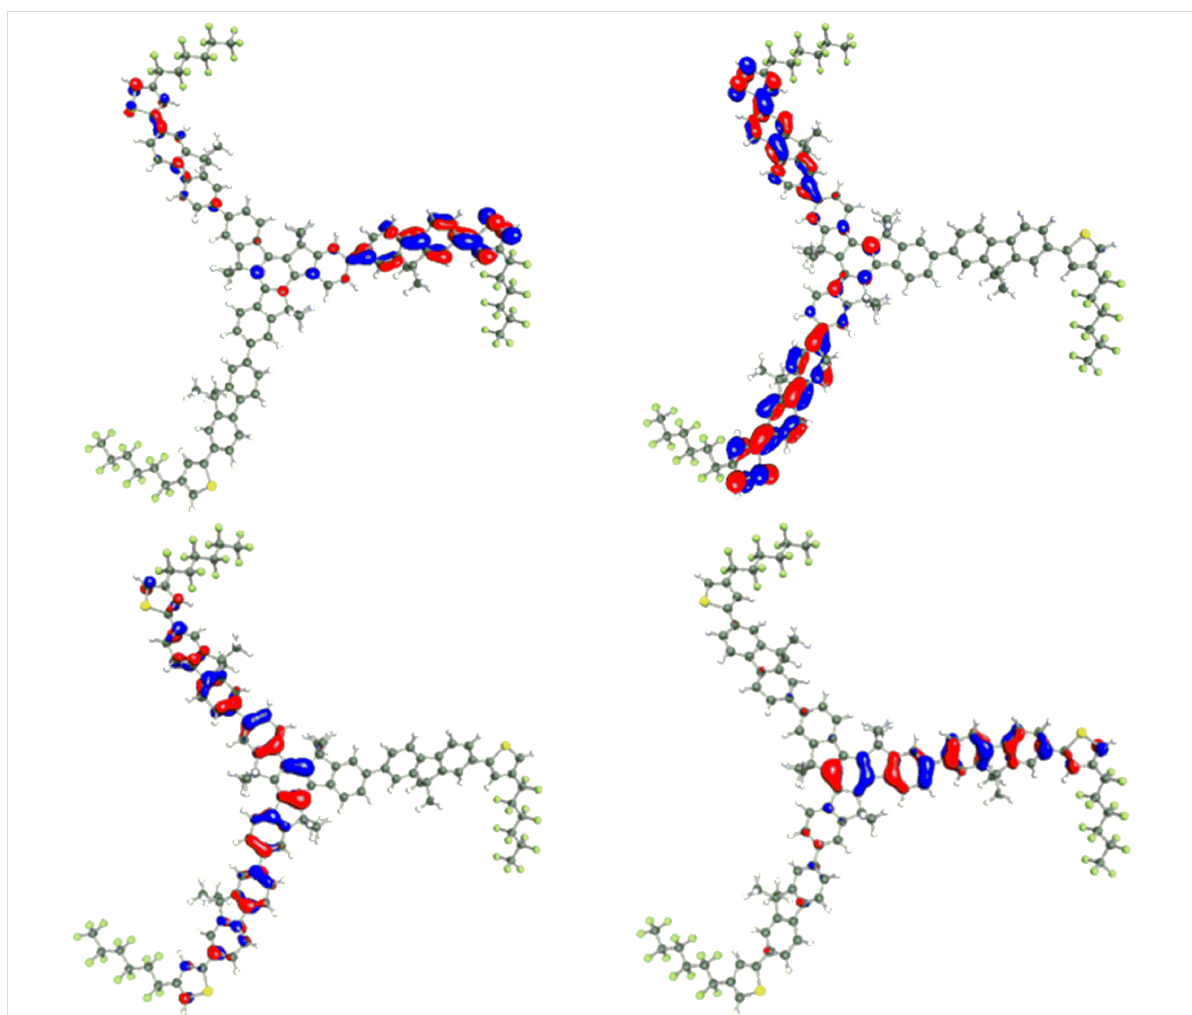
Figure 4: HOMO − 1 (bottom, left), HOMO (bottom, right), LUMO (top, left) and LUMO+1 (top, right) of T1- 4 FTh .